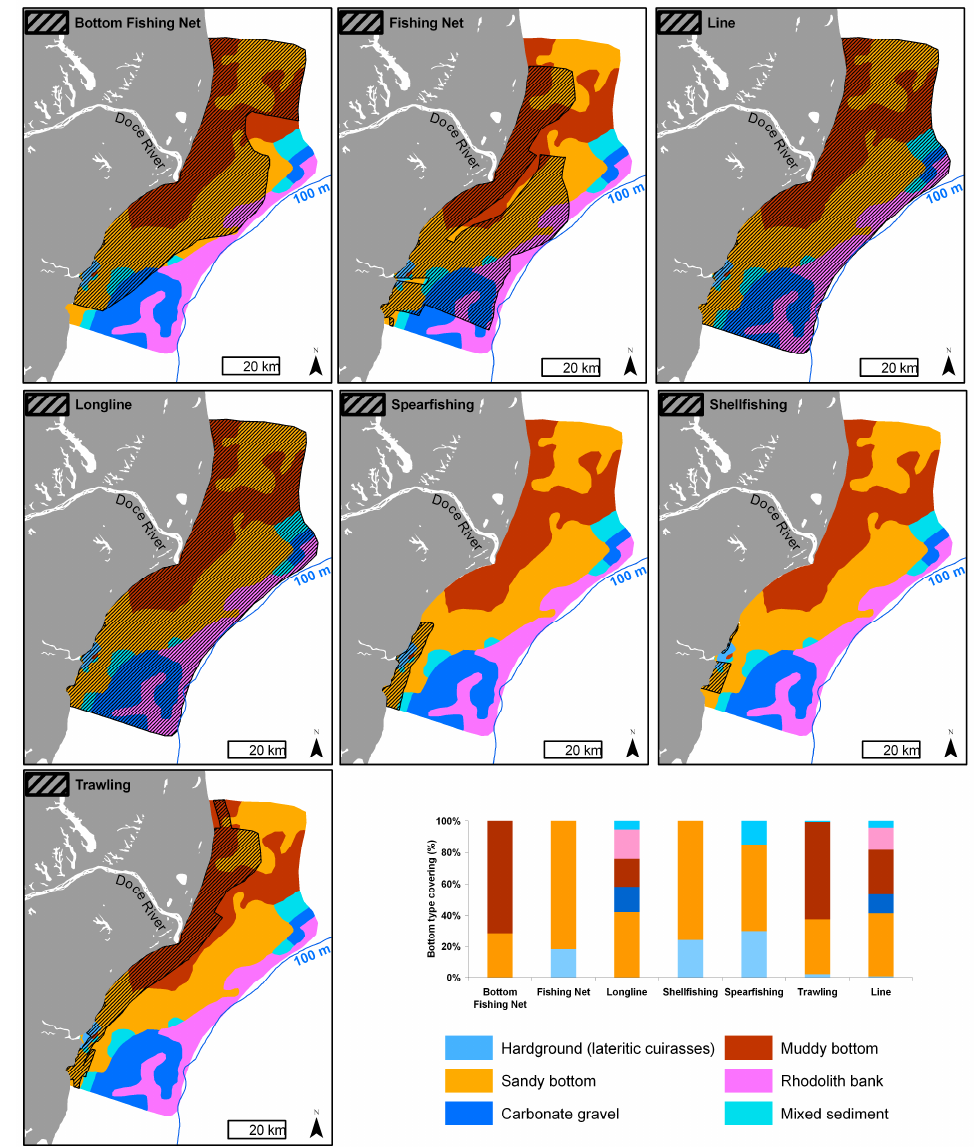
Figure 6. Relationship between different fisheries types and sedimentary facies. The graph shows the percent cover of each fishery in the distinct sedimentary domains. percent cover of each fishery in the distinct sedimentary